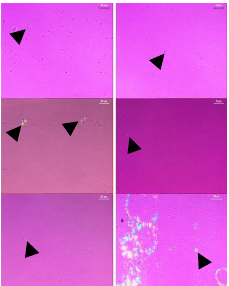
Figure 4. Polarizing micrograph of (1) linolenate-linolenic acid vesicle and (2) PEGylated linolenate-linolenic acid vesicle at pH (A) 7.5, (B) 8.5 and (C)